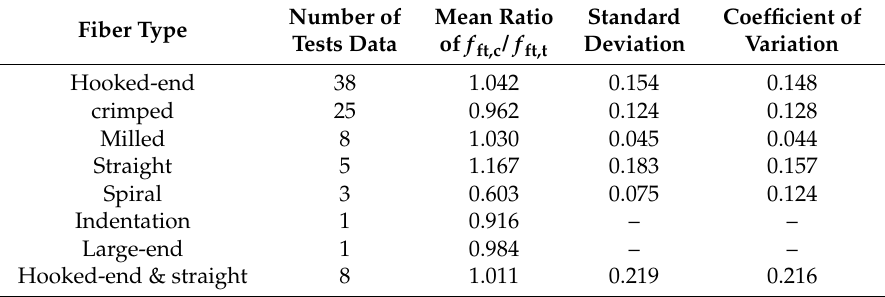
Figure 9. Comparison of calculated and measured values of tensile strength for SC-SFRC using Equations (6) and (7). Table 3. Comparison of f ft,c and f ft,t of SC-SFRC.